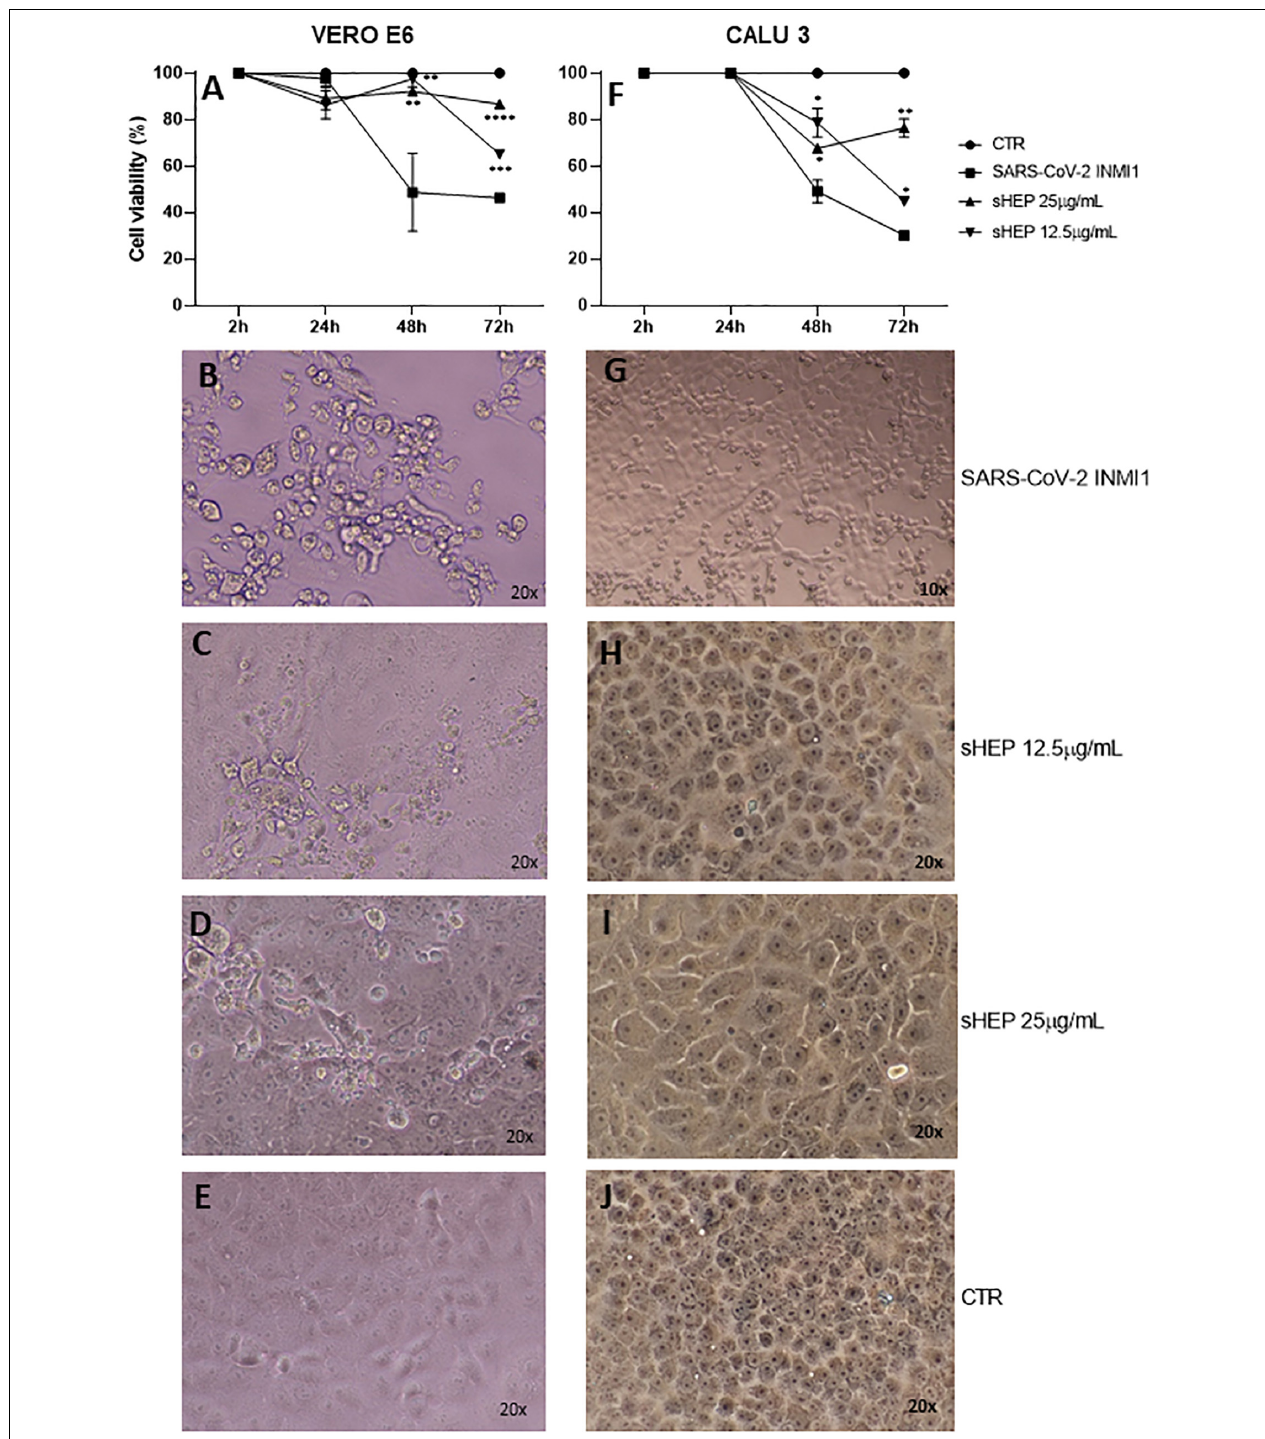
FIGURE 1 | Effects of sHEP addition in the medium of culture of SARS-CoV-2 infected VERO E6 and CALU3. Panels (A,F) VERO E6 and CALU3 cell viability was measured with CellTiter-Glo R (cid:13) Luminescent Cell Viability Assay. After SARS-CoV-2 infection (MOI0.001) for l h at 37 ◦ C and sHEP addition in the culture medium, cell viability was assessed at each indicated time points and compared with that of control infected cells. Data points represent the mean (+SD) of three independent experiments. Panels (B–D) and panels (G–I) show light microscopy images of VERO E6 and CALU 3 cell lines, respectively, 48 h after SARS-CoV-2 infection and culture in presence of sHEP at indicated concentrations. Panels (E,J) refer to control uninfected cells. The asterisks indicate statistically significant differences determined by Student’s t -test (**** p < 0.0001; *** p < 0.001; ** p < 0.01; * p < 0.05; no asterisk, p ≥ 0.05) between infected cell and those infected and cultured in presence of